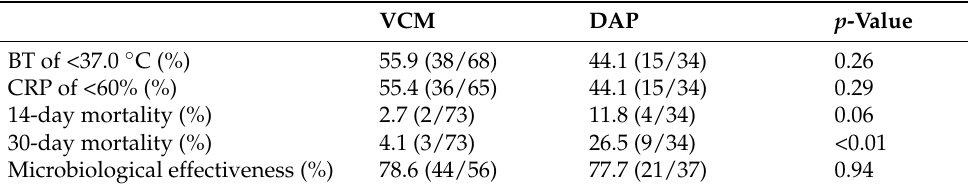
Table 2. Clinical and microbiological effectiveness of the registered patients.